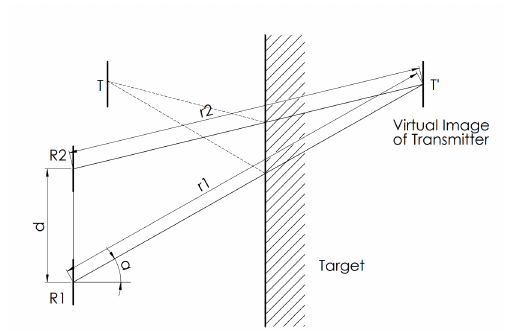
Figure 3. Indirect measurement setup according to [13].